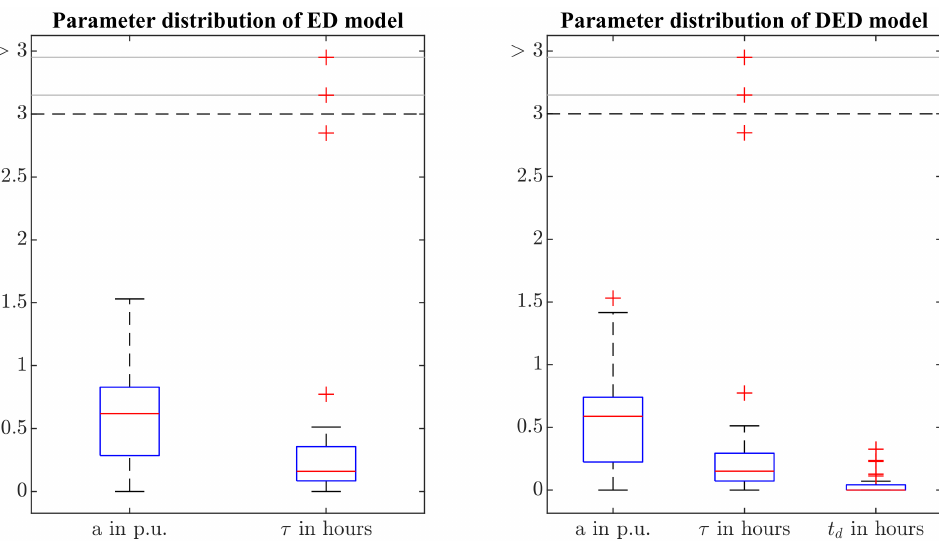
Figure 6. Distribution of fitted model parameters: Red crosses are outliers beyond 1.5 time the interquartile range. The y -axis is compressed for values beyond